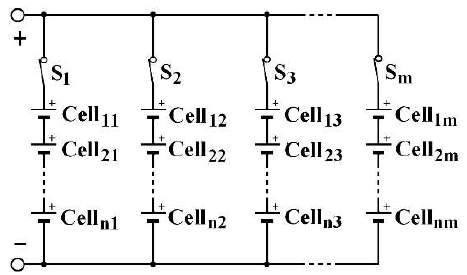
Figure 2. SP (series-parallel) architecture.